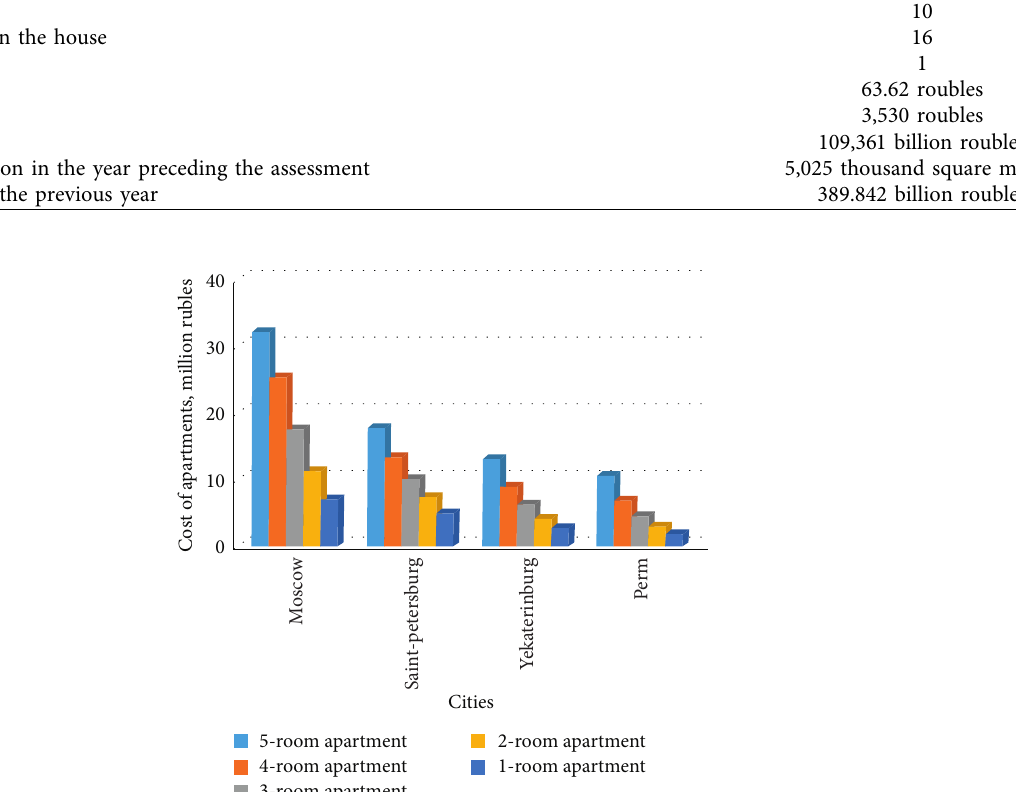
Figure 3: Results of computer experiments on virtual relocation of a residential building from Moscow to St. Petersburg, Yekaterinburg, and Perm.